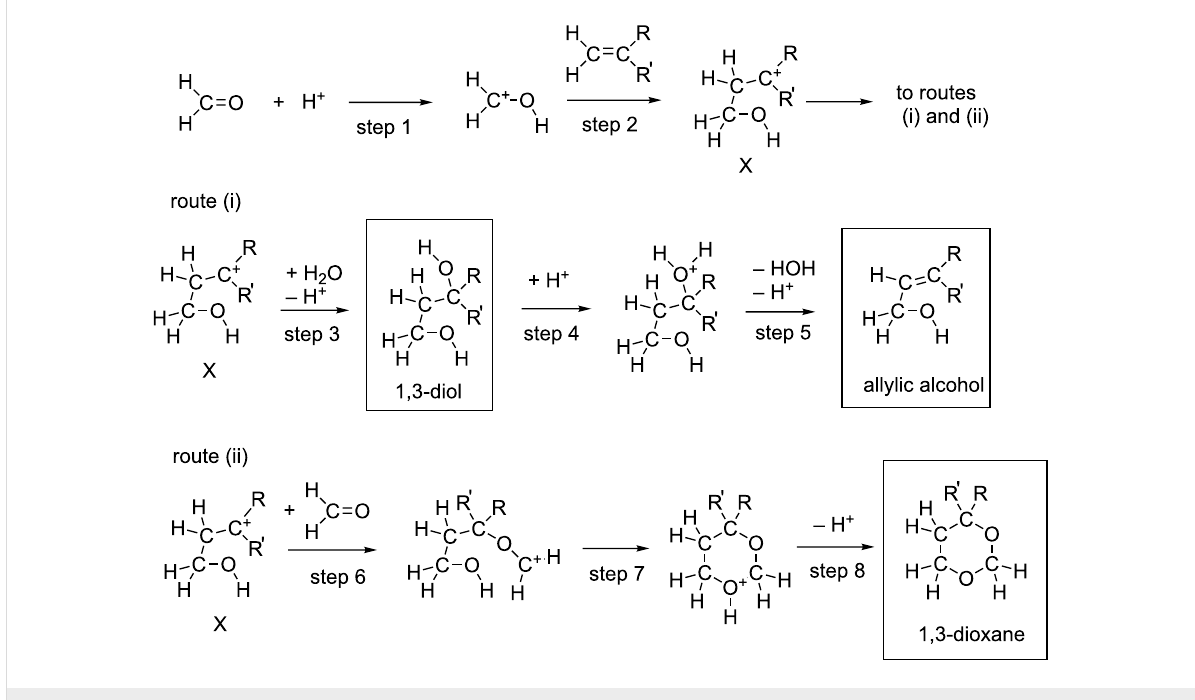
Scheme 5: A reaction mechanism involving the carbonium-ion intermediate X.